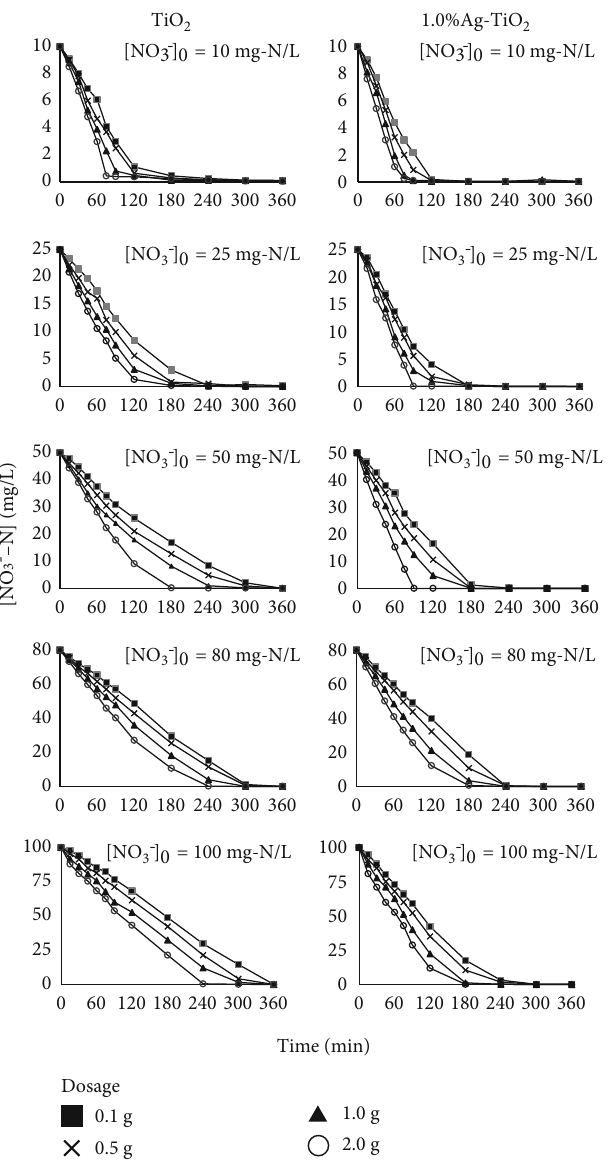
Figure 4: The concentrations of NO −